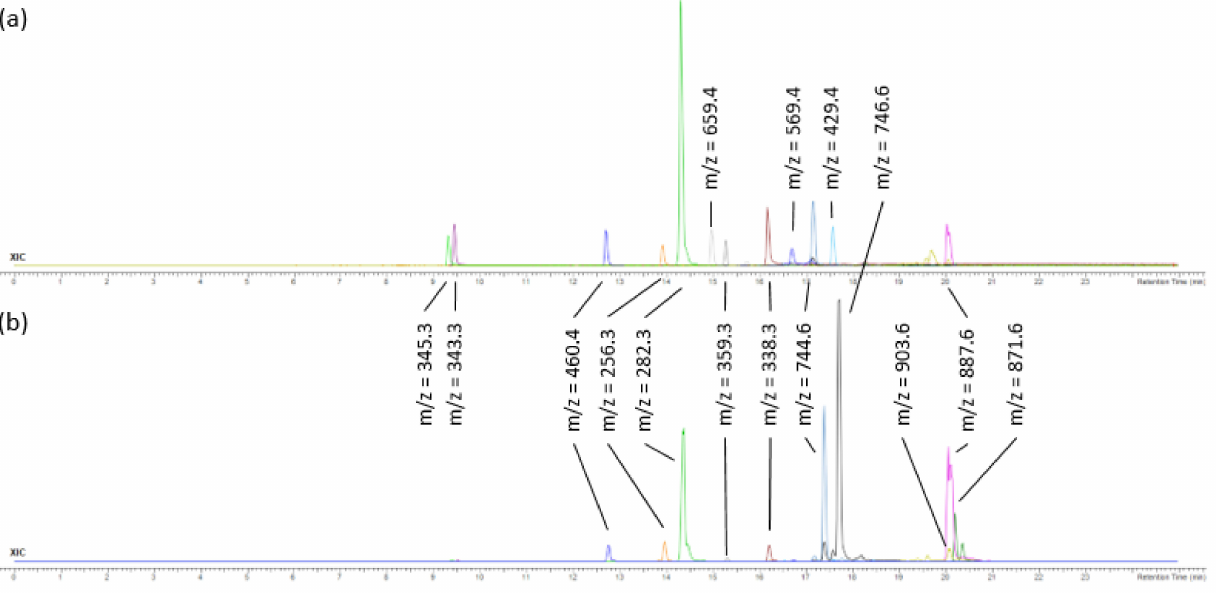
Figure 2. Extracted ion chromatograms (XIC) of the most abundant ions in the fractions ( a ) F3 and ( b )